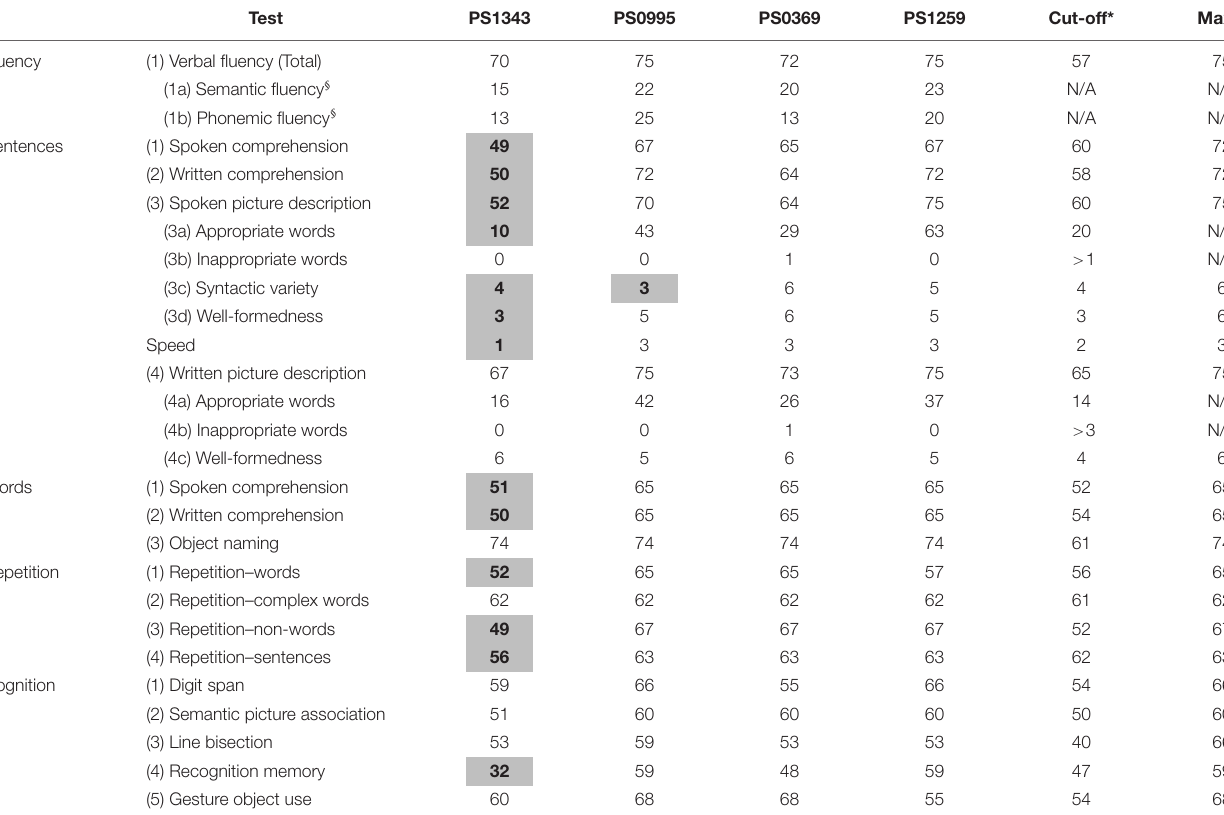
TABLE 2 | Comprehensive aphasia test t-scores obtained by